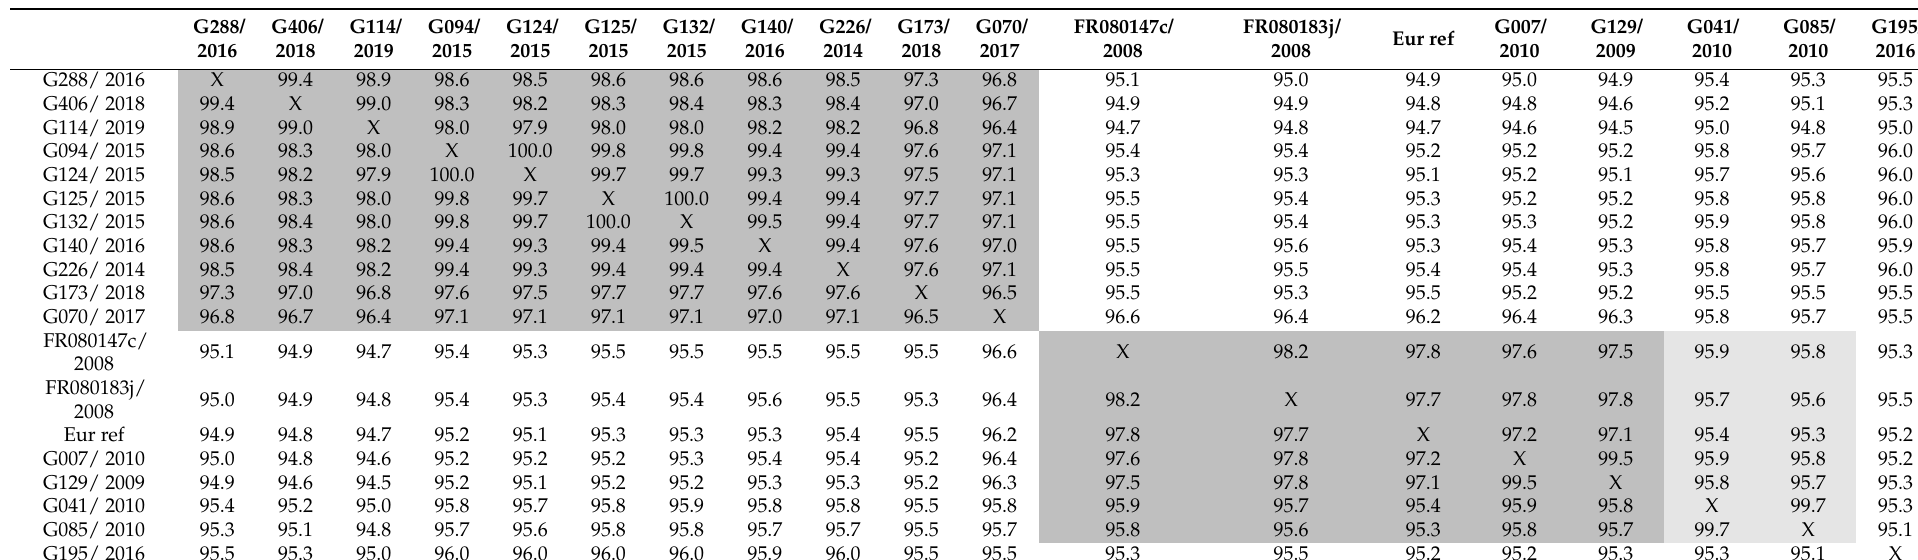
Table 3. Sequence identity of S gene of Polish TCoVs and European reference strains from